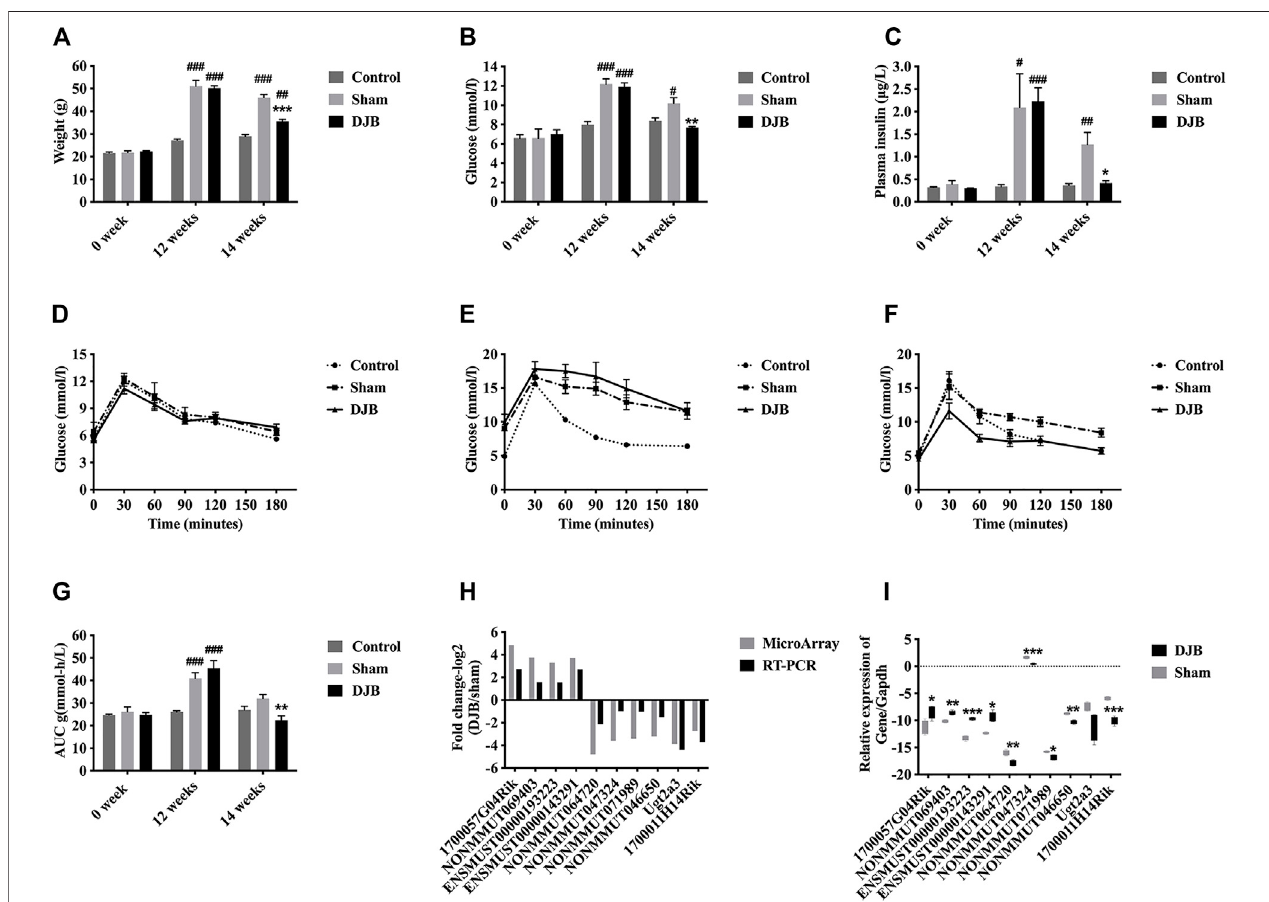
FIGURE 8 | Microarray validation. Weight (A) , FBG (B) , plasma insulin (C) , OGTT (D) , week 0 (E) , week 12 (F) , and week 14 and AUC (G) of another cohort of diabeticmice. (H) HistogramsshowingthecomparisonbetweenmicroarraydataandqRT-PCRresultsof10transcripts. (I) BoxplotshowingtheqRT-PCRresultsofthe 10 transcripts with another cohort of mice. All values are shown as mean ± SEM. Statistical differences were analyzed by the Student ’ s t -test. * For DJB group versus sham group, # for DJB or sham group versus control group (* p < 0 .05, ** p < 0 .01, *** p < 0 .001, # p < 0 .05, ## p < 0 .01, ### p < 0 .001).